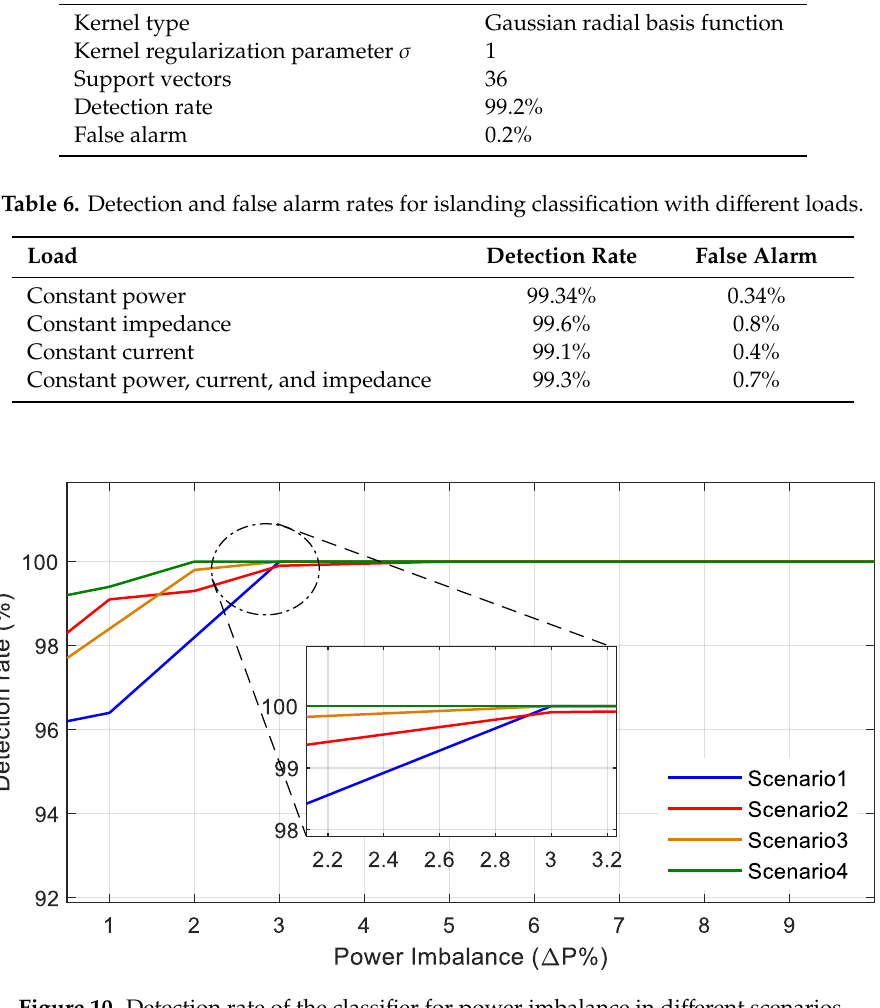
Table 6. Detection and false alarm rates for islanding classification with different loads.